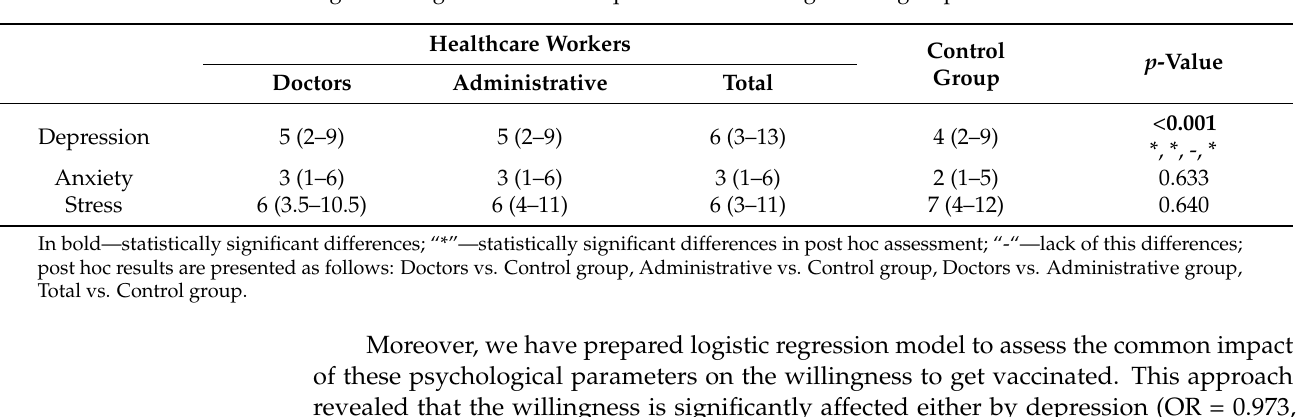
Table 4. Mental well-being according to the DASS-21 questionnaire among control group and healthcare